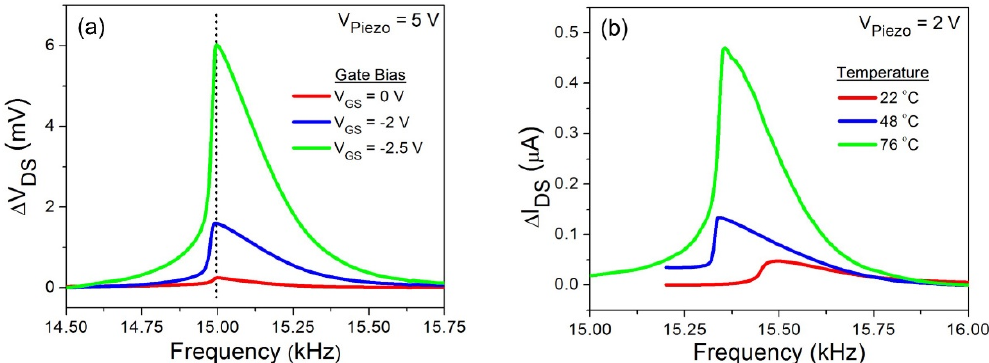
Figure 5. ( a ) Effects of different gate biases on the cantilever resonance in the softening-dominant nonlinear regime. Increasing the gate bias, which alters the HFET sensitivity, does not change the cantilever nonlinear response. ( b ) Temperature influence on the nonlinear response of VO 2 thin film embedded microcantilever excited at V Piezo = 2 V. Temperature not only modifies the sensitivity of the VO 2 thin film, but also changes the nonlinear behavior of the cantilever.